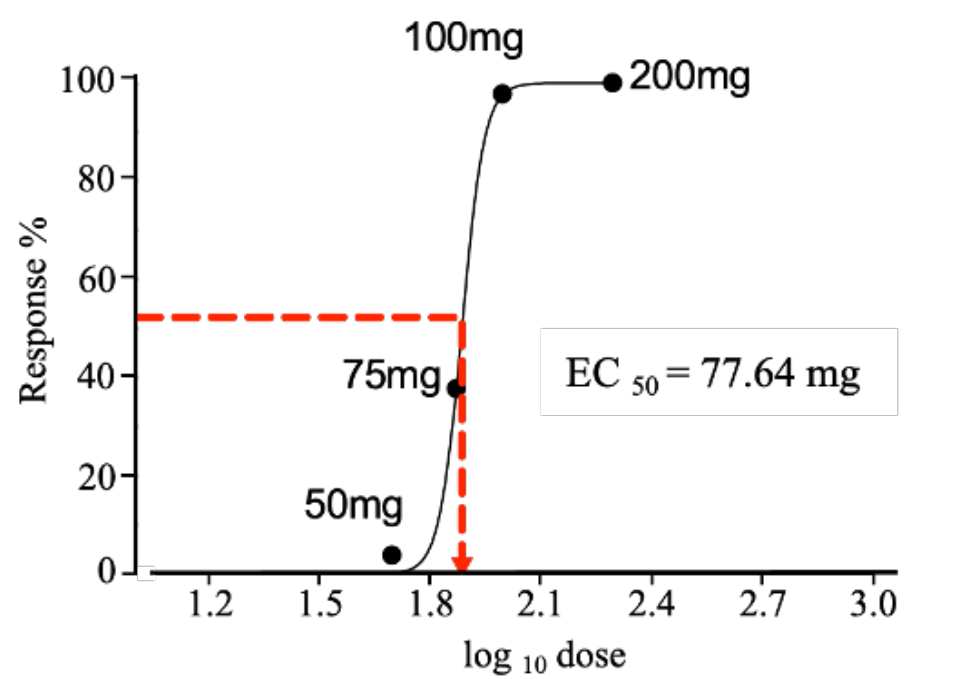
Figure 4. The s-shaped curve showing the dose-response relationship. The dose of tranilast is plotted as the log10 dose on the x -axis. The effect of the drugs as responses are plotted on the y -axis. The effect of tranilast (pain threshold) increased with increasing doses. The effects of tranilast increased up to 100 mg, and no further increases were seen beyond 100 mg, as 200 mg also showed the same response. The effective dose with which to achieve 50% of the maximum response (EC 50 ) was determined to be 77.64 mg.